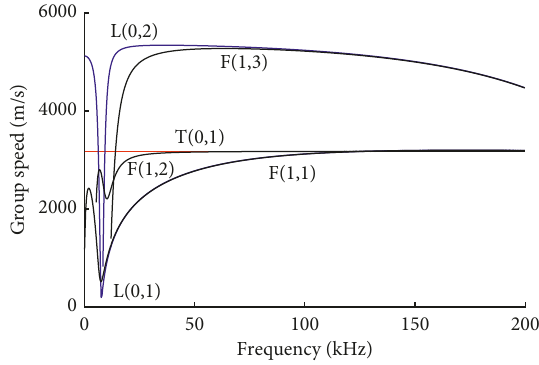
Figure 1: Group velocity dispersion curve.